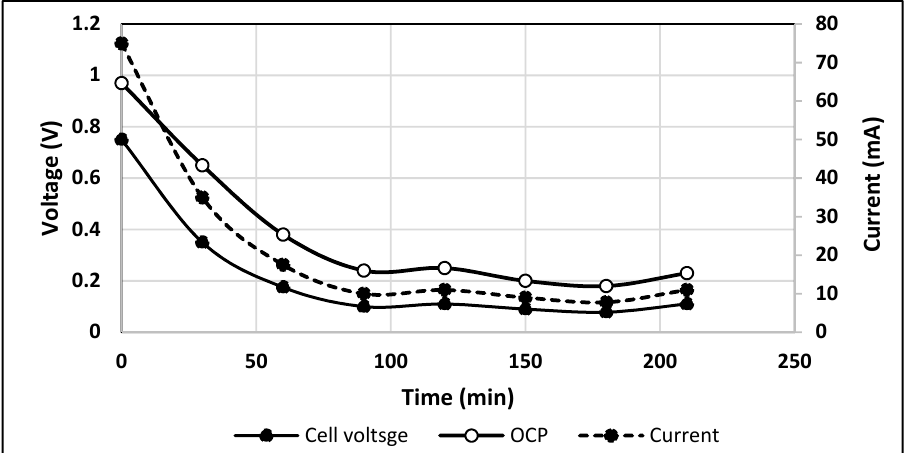
Figure 6. Time profile of cell voltage, open circuit potential (OCP) and electric current for a discharge of a two fuel cell stack, aerated by direct aeration. Feeding flow rate for cathode compartments 1 dm − 3 /h each. Feeding sulfide concentration 77.1 mg dm − 3 . Feeding flow rate for anode compart- ment 0.4 dm 3 /h each. Load resistance 10 Ω . Temperature 20 ◦